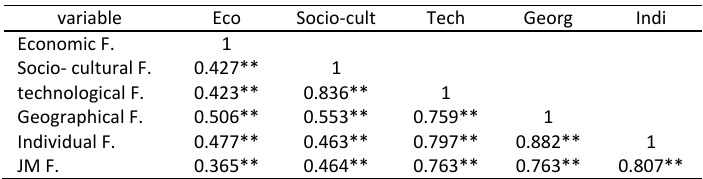
Table7: Research variable correlation